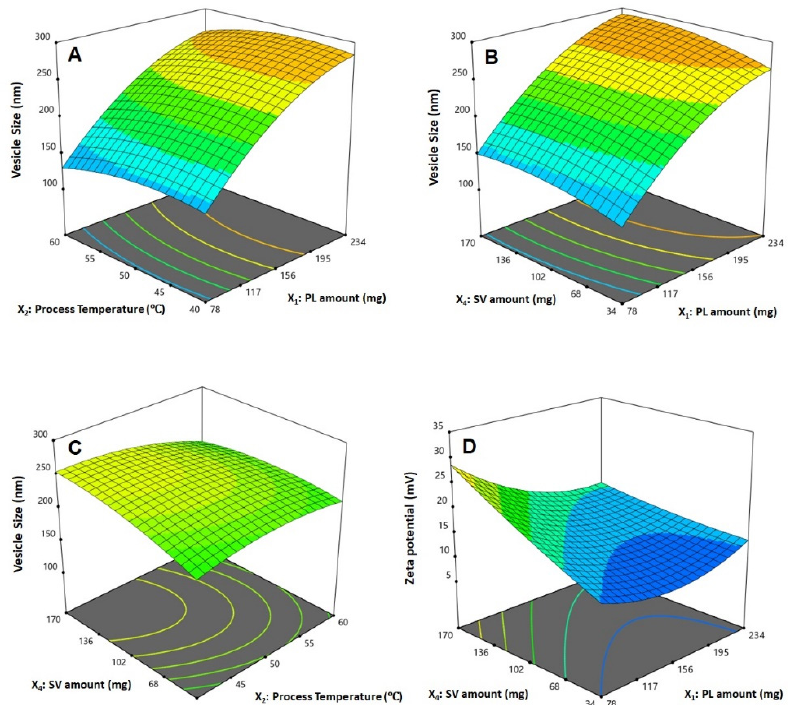
Figure 4. Response surface 3D plots showing the effect and interaction between the significant factors on the vesicle size ( A – C ) and zeta potential ( D ) of QRT-PHM-SV formulations. Abbreviations: QRT, quercetin; PHM, phytosomes; SV, scorpion venom peptide.